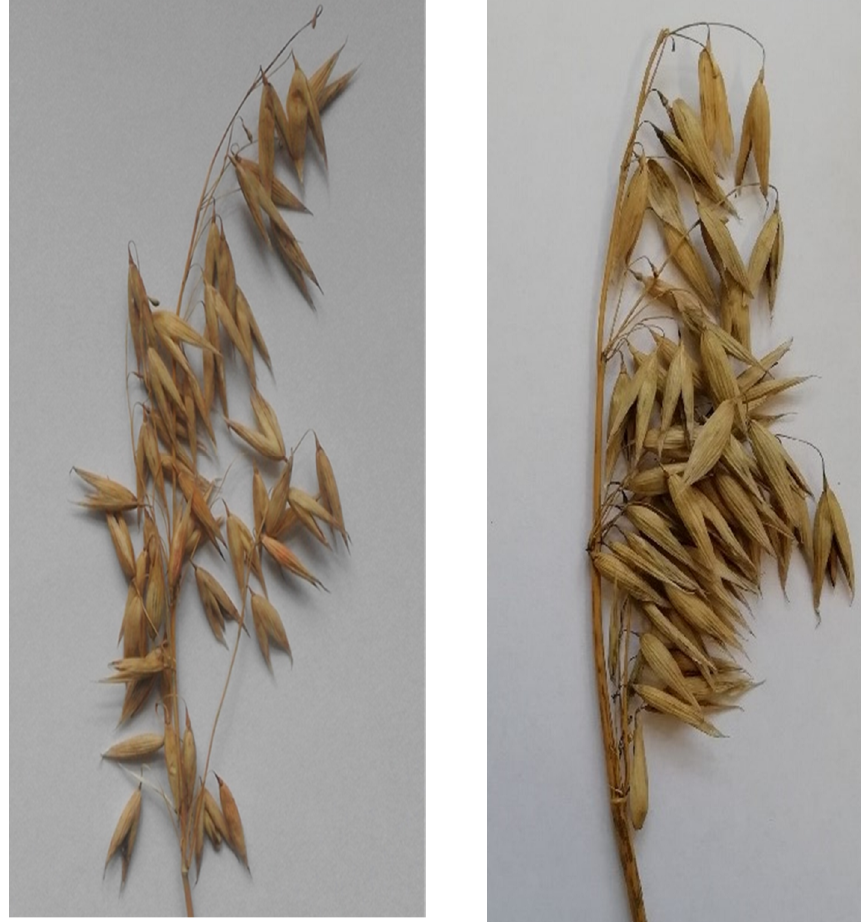
Figure 1. Oat panicles after inoculation with F. equiseti ( left ) and control ( right ).